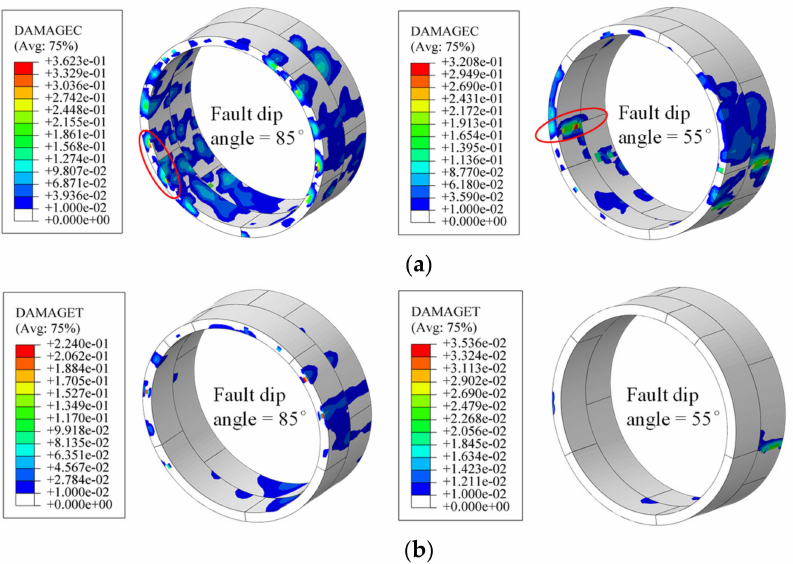
Figure 24. Development of structural damage changing with fault dip angle under reverse faulting: ( a ) compression damage of segments and ( b ) tensile damage of segments. Some like +3.623e-01 means 3.623 × 10 − 1 .